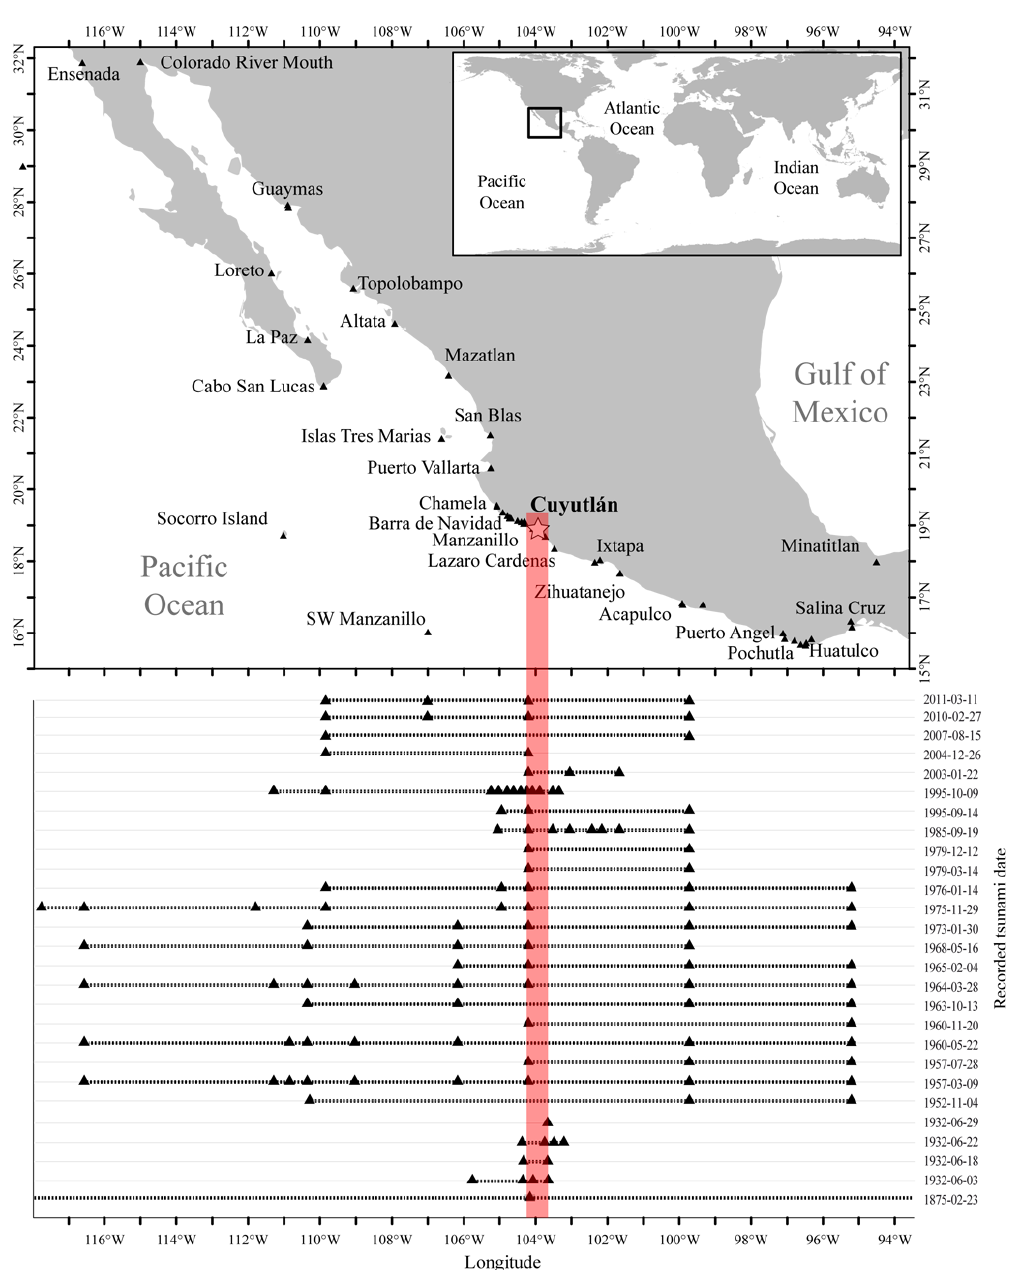
Fig. 1. Coastline affected by historical tsunamis that have reached Cuyutl´an. Black triangles, location that reported tsunamis (HTDB/WLD, 2011; NGDC, 2011) from 1875–2011; dash lines, probable tsunami affected longitude on each date, but without record on corresponding locations. Red vertical band, study area, Cuyutl´an